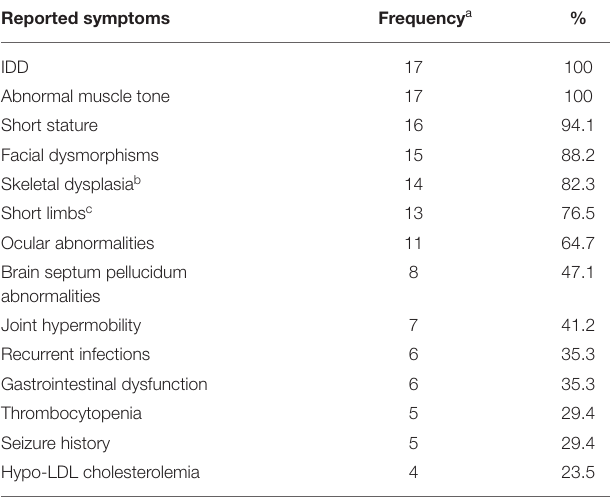
TABLE 3 | Overview of disease features in 17 reported NANS-CDG